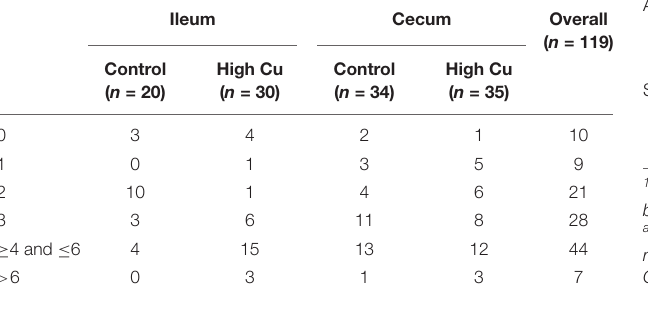
TABLE 3 | Number of antimicrobial multiresistant E. coli isolates in ileum and cecum. Ileum Cecum Overall